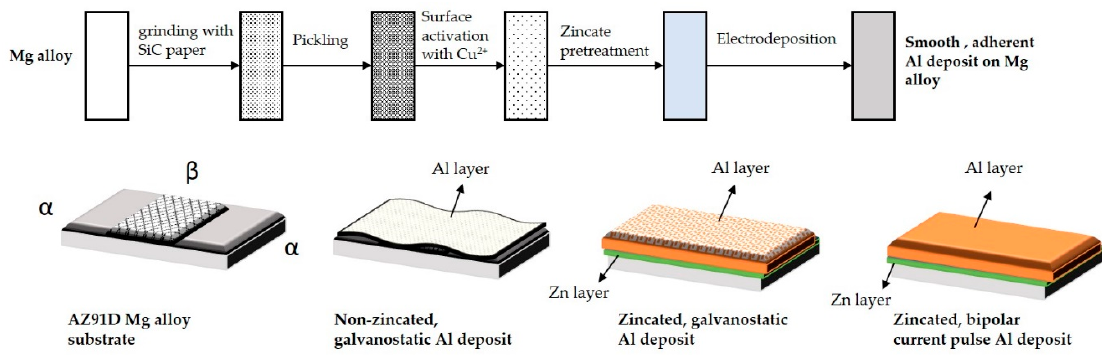
Figure 7. Schematic showing the effect of zincating pretreatment of AZ91D Mg alloys prior to Al deposition and the mode of deposition on the Al deposit [92]. Green layer indicates the Mg alloy substrate after zincate pretreatment. Orange layer indicates the Al deposited on the zincated substrate.